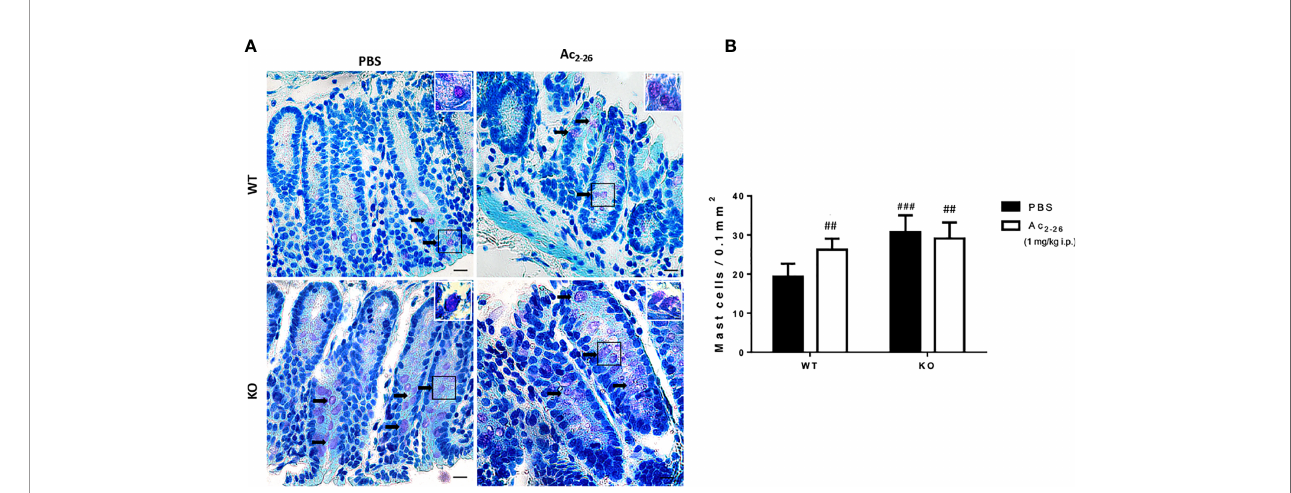
FIGURE 1 | Histological analysis of the distal colon of C57BL/6 WT and C57BL/6 IL-4 KO mice. (A) Representative colon sections after PBS or peptide Ac2-26 treatment (1 mg/kg i.p.). Arrows indicate examples of MCs in the tissue. Insets show higher magni fi cation. Staining: Toluidine Blue. Sections: 4 m m. Scale bars: 20 m m. (B) Quantitative analysis of MCs in the colon fragments. Experiments were performed twice with n = 4 animals/group. Results of cell numbers/mm 2 are expressed as the mean ± S.D, n = 8. Data were analyzed using one-way ANOVA. ## p <0.01 compared to WT PBS group. ### p <0.001 compared to WT PBS